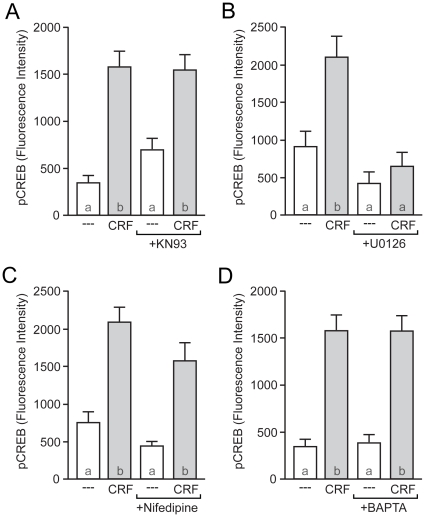
CRF-induced CREB phosphorylation occurs via a MEK/MAPK-dependent mechanism.(A) The CaMK inhibitor KN-93 (2 µM) did not affect CRF-induced CREB phosphorylation (F = 17.65). (B) CRF-induced CREB phosphorylation was blocked by the MEK antagonist U0126 (10 µM; F = 11.97). (C) The L-type Ca2+ channel blocker nifedipine (5 µM) had no effect on CRF-induced CREB phosphorylation (F = 18.50). (D) Chelating intracellular calcium with BAPTA-AM (30 min incubation with 5 µM) failed to block CRF-induced CREB phosphorylation (F = 12.72).